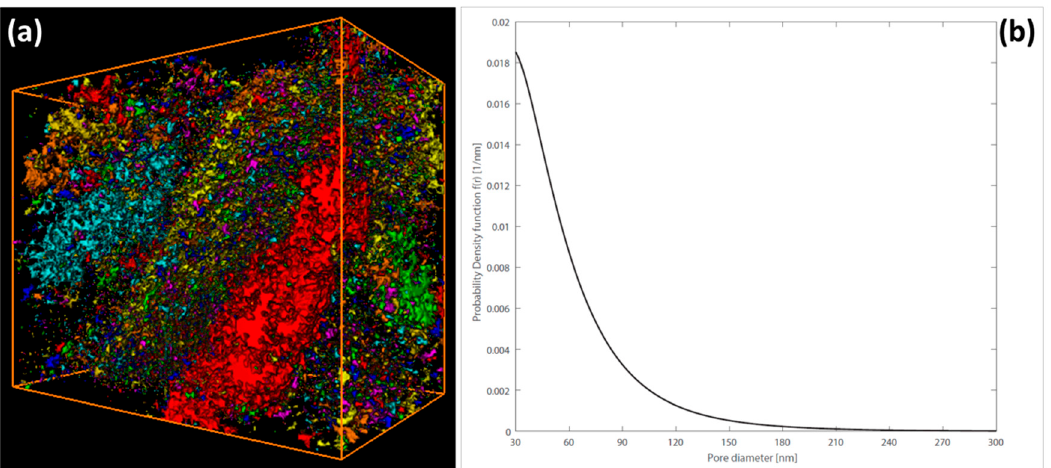
Figure 11. Pore size distribution in the obtained volume from the olivine sample. ( a ) Labelled pores painted in different colours; ( b ) probability density function of labelled pores size distribution.